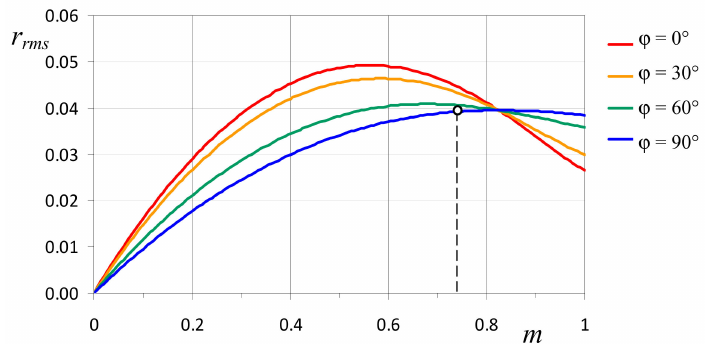
Figure 7. Root-mean-square (RMS) of normalized voltage switching ripple vs. modulation index for different output phase angles ϕ = 0 ◦ , 30 ◦ , 60 ◦ , and 90 ◦